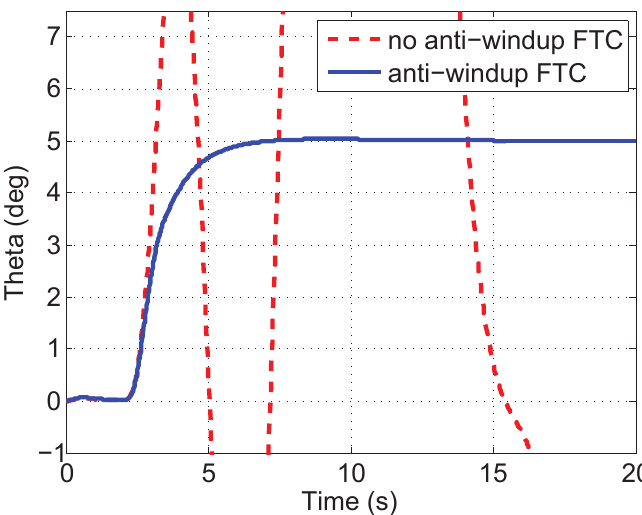
Figure 5. Effect of the integrated fault-tolerant strategy.